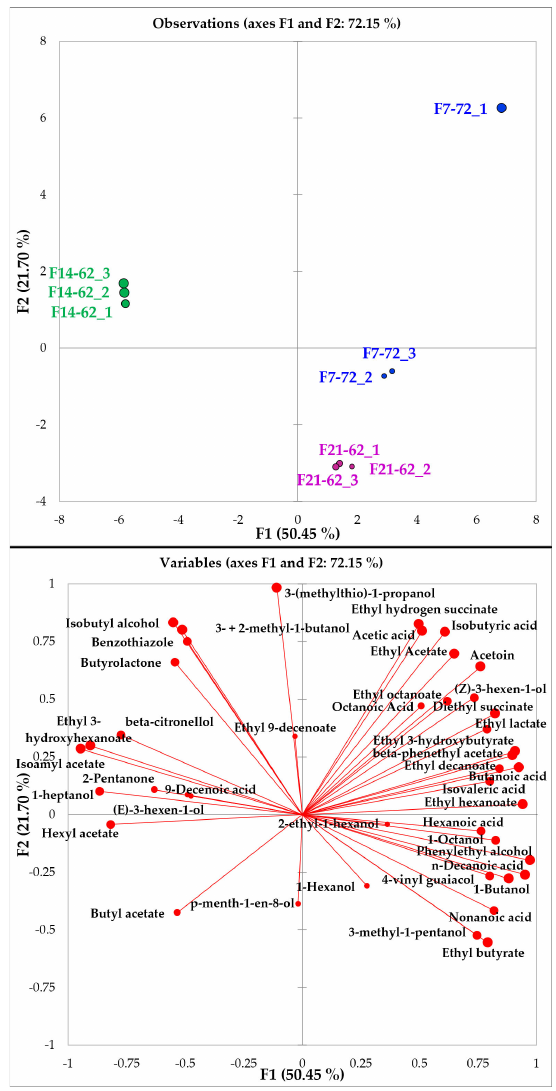
Figure 3. PCA biplots (Pearson correlations; α < 0.05) illustrating wine samples ( a ) and volatiles ( b ) on the first two components representing 72.15% of the total